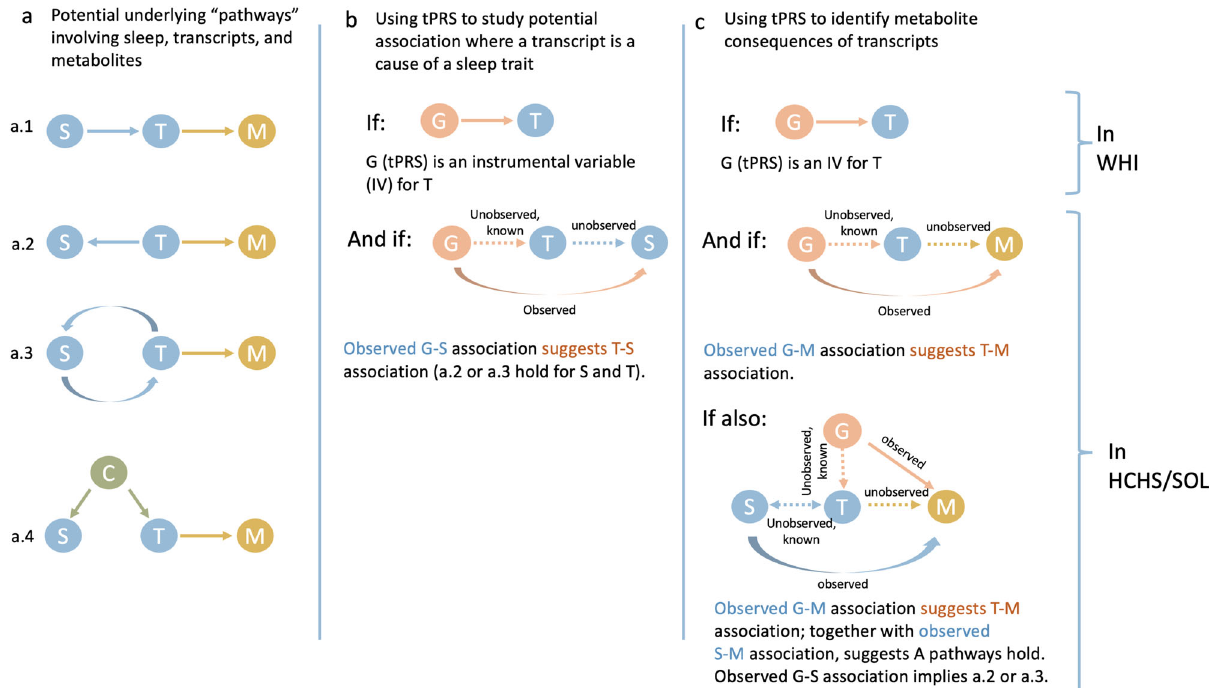
Fig. 3 Potential association “ chains ” of SDB traits, transcript expression, and metabolites, addressed in this study. The fi gure illustrates association chains, or pathways, potentially linking an SDB trait, a transcript, and a metabolite. Here we assume that an association between a sleep trait and a transcript was detected in MESA and is assumed “ known ” for follow-up analysis in WHI in HCHS/SOL. a demonstrates potential forms of causal associations between the sleep trait and the transcript, including (a.4) the settings where an association exists due to a common cause, e.g., BMI. Our metabolomics analysis may only detect transcript – metabolite associations, i.e., any sleep – metabolite link is via transcript levels. b demonstrates a potential conclusion from an association between a tPRS, validated in WHI and used as an instrumental variable (IV) of a transcript, and a sleep trait: if an association is detected, it provides evidence that changes in transcript levels are upstream (a cause of) changes in sleep trait levels. c demonstrates potential conclusions from analyses linking tPRS and a sleep trait to a metabolite. A tPRS is used to link a transcript to a metabolite, and an association, if exists, is likely causal. A sleep – metabolite association should exist if the sleep – transcript and tPRS – transcript associations hold, and therefore observing such an association validates the existence of any of A pathways. Further association between the tPRS and the sleep trait narrows down the potential association chains to a.2 or